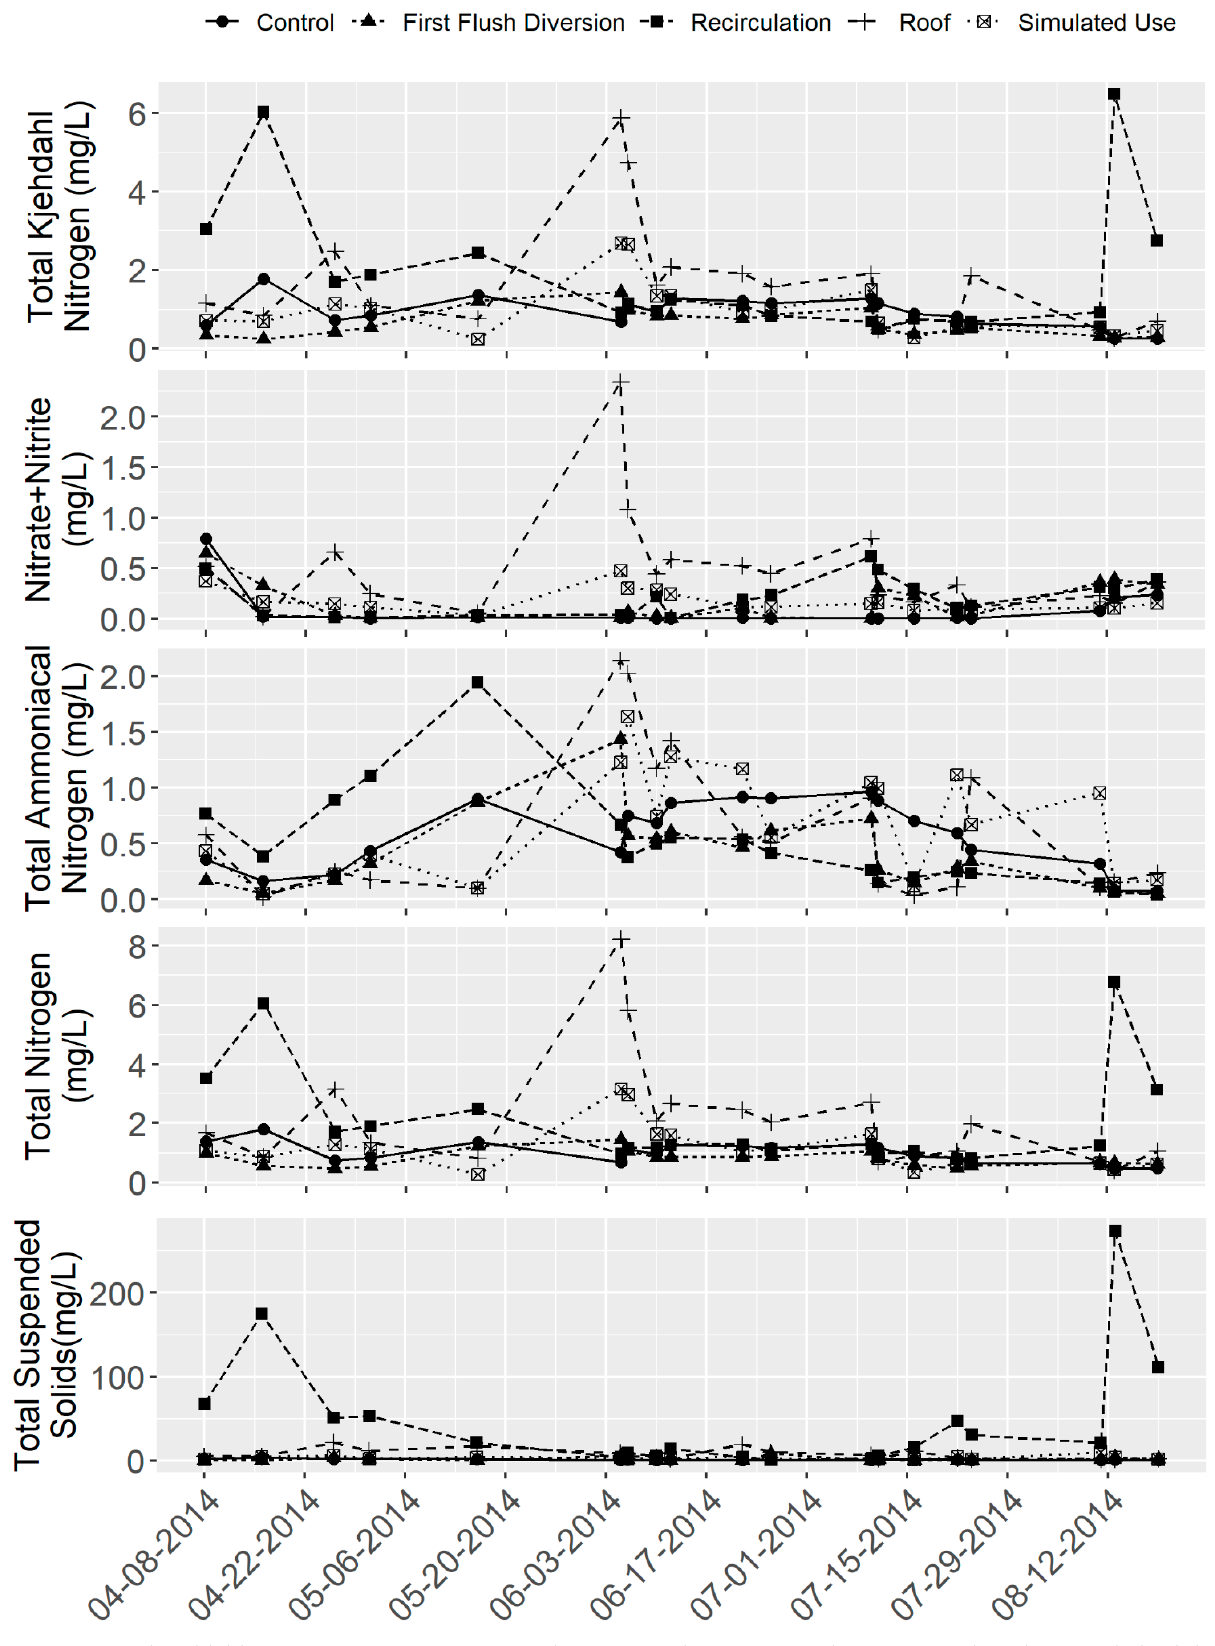
Figure 6. Total Kjeldahl nitrogen, nitrate + nitrite, total ammoniacal nitrogen, total nitrogen, and total suspended solids concentrations measured in roof runoff and rainwater tank samples during the study period.